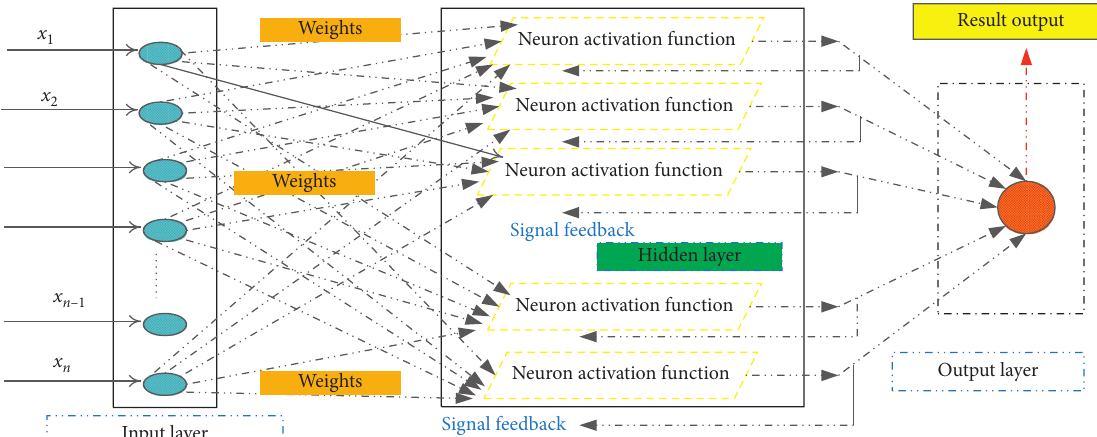
Figure 1: Neuron model